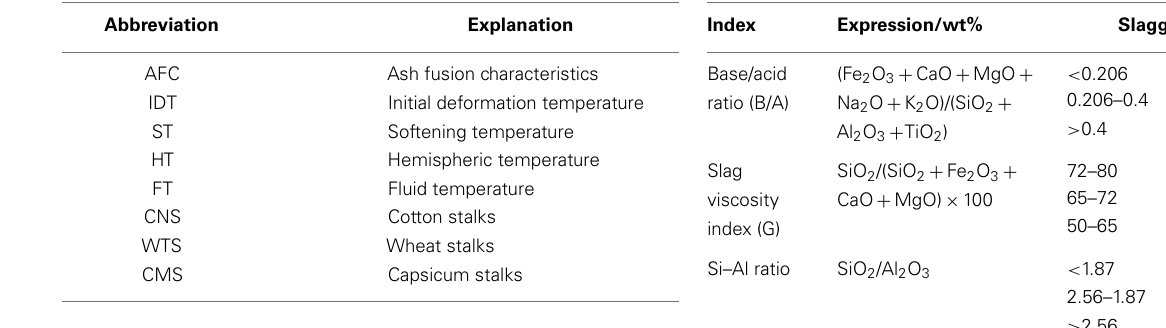
Table 3 |Abbreviations used in the section. Table 4 | Several frequently used criteria for coal ash fusion